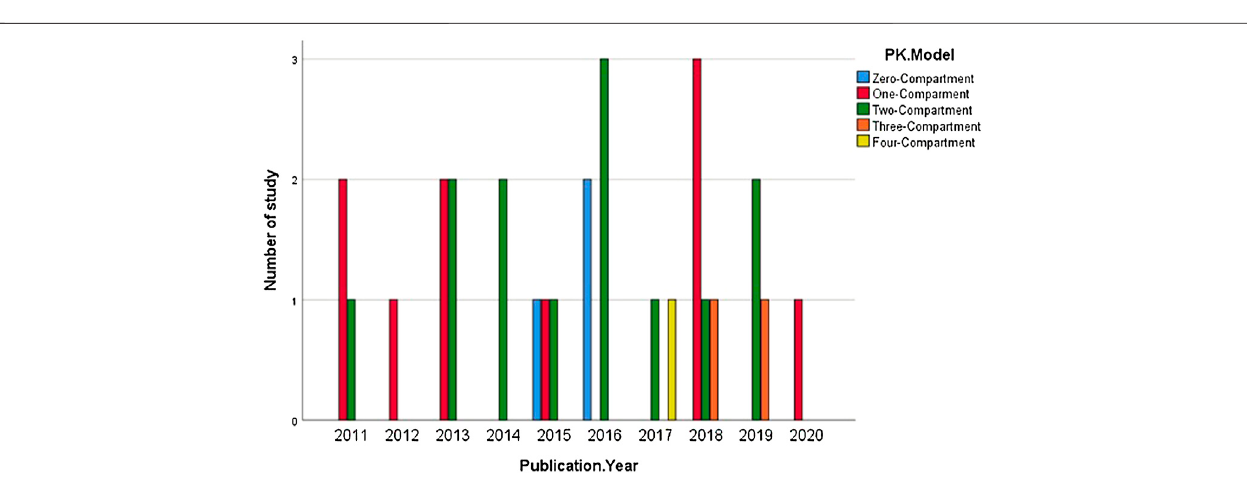
FIGURE 4 | Distribution of different types of PK models.